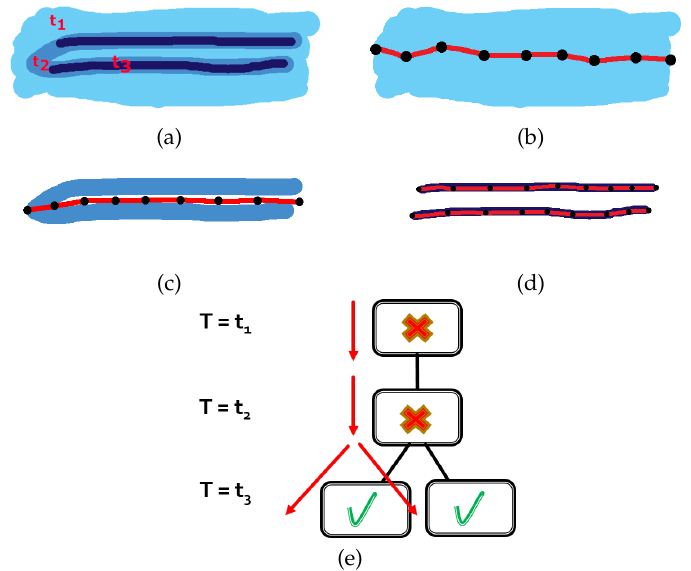
Figure 5. Illustration of thresholding on a synthetic component. ( a ) Component is composed of three gray levels with ascending values t 1 , t 2 , t 3 . ( b – d ) Child components from thresholding the parent component with T ≥ t 1 , t 2 , t 3 respectively and their approximating splines. ( e ) Bread first traversal of the component